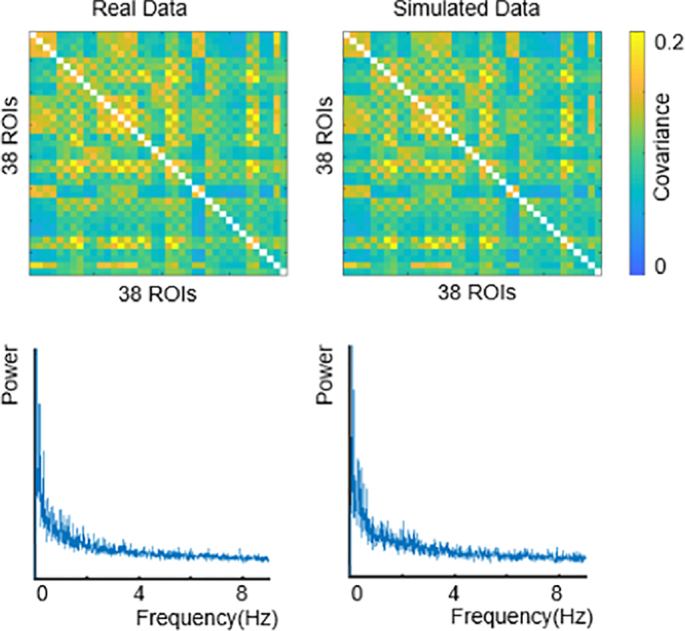
The full-length real and simulated multivariate datasets were matched in covariance and spectra. Shown are covariance matrices (top) and average power spectra (bottom) for the real CH dataset (left) and a corresponding simulated dataset (right).